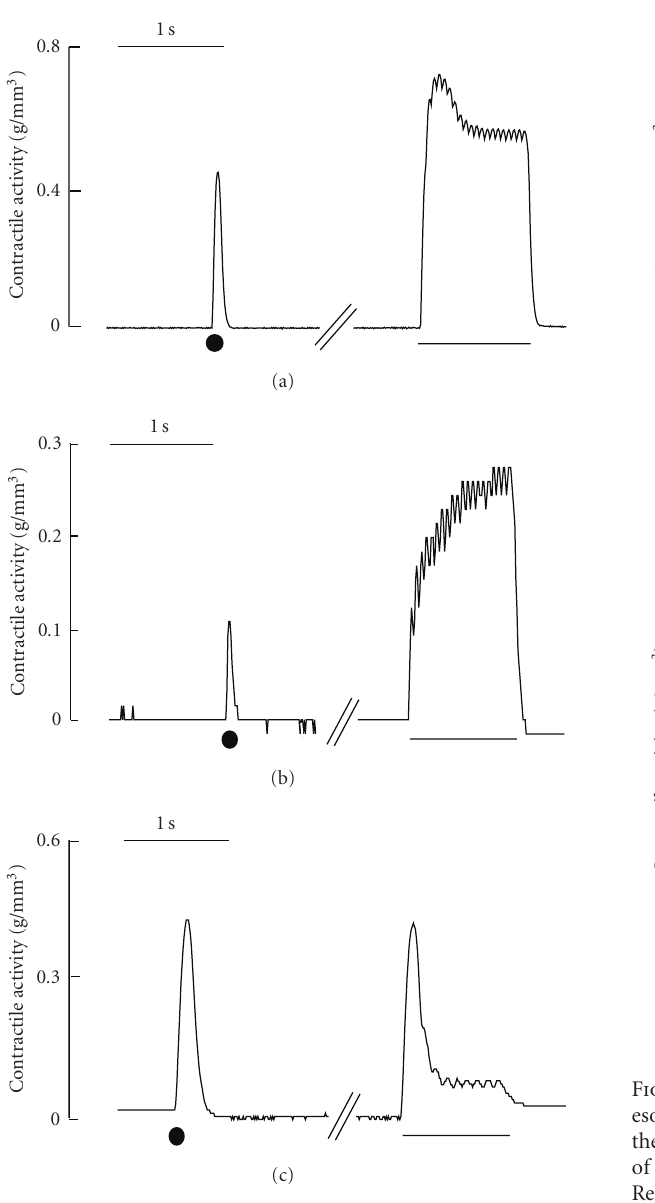
Figure 2: Multipulse electrical stimulation-induced contractile responses of esophageal, skeletal, and cardiac muscles. Represen- tative traces of the contractile responses to single and multipulse repeated EFS in esophageal (a), skeletal (b), and cardiac (c) muscle preparations are shown. Similar results were reproducibly obtained in five independent experiments. EFS was applied by using single or repeated pulses (80V-10ms, 20Hz for 1 s). Closed circles and underbars indicate the points of single EFS and the location of multiple EFS, respectively.